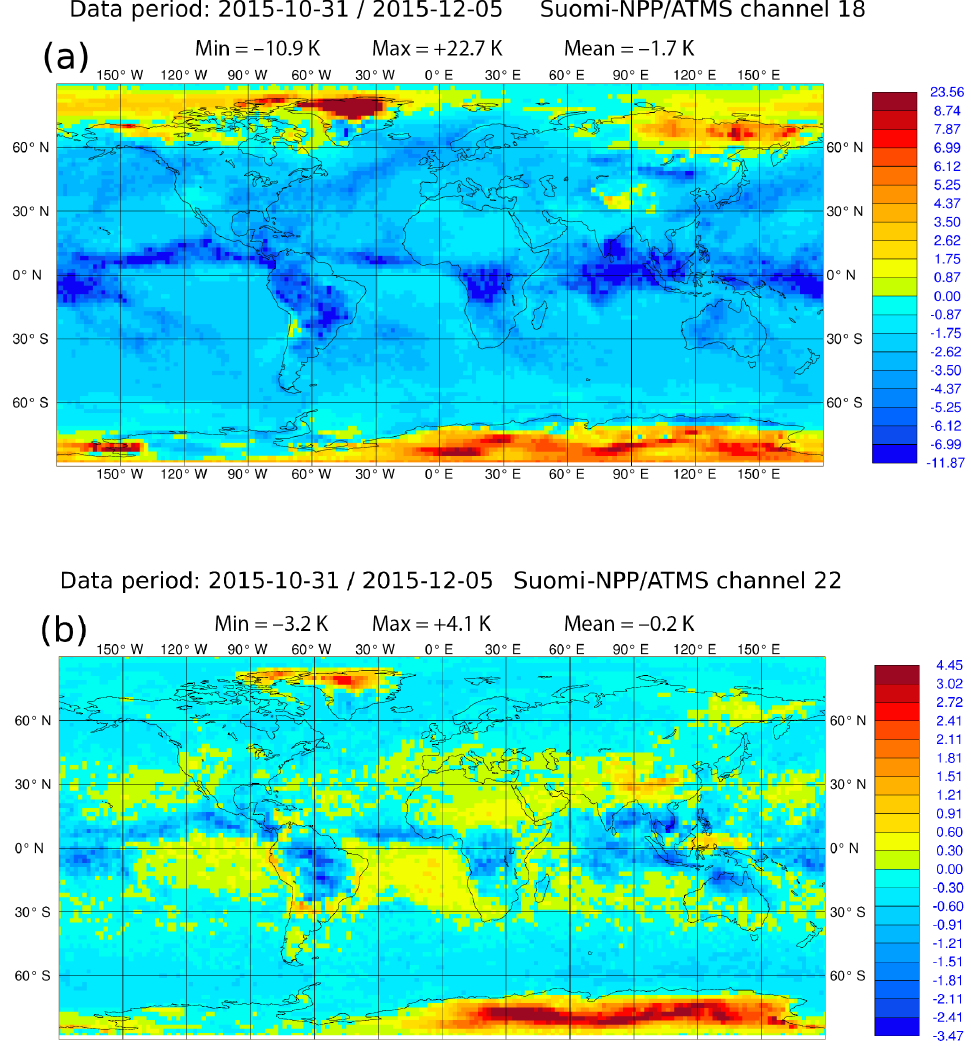
Figure 2. First-guess departures (observed BTs – those calculated from the forecast background) for Suomi-NPP/ATMS (a) channel 18 (183 ± 7GHz) and (b) channel 22 (183 ± 1GHz) and the current ECMWF NWP system. The maps show the mean, with the global minima, maxima and means in the